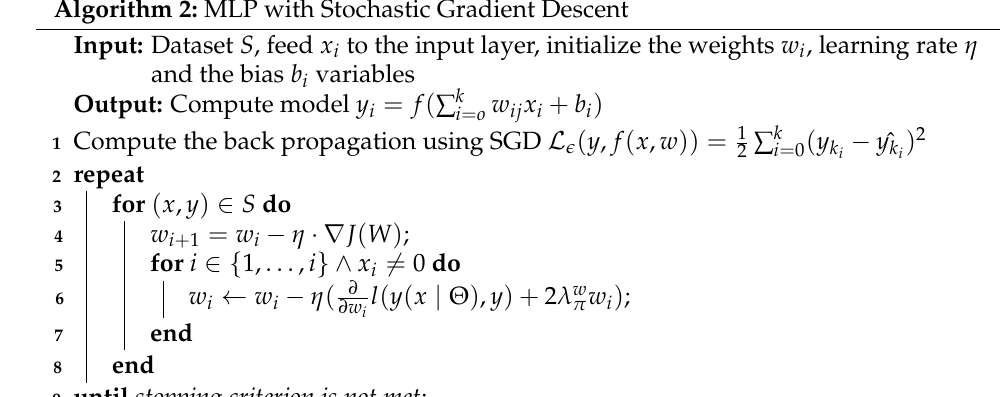
Algorithm 2: MLP with Stochastic Gradient